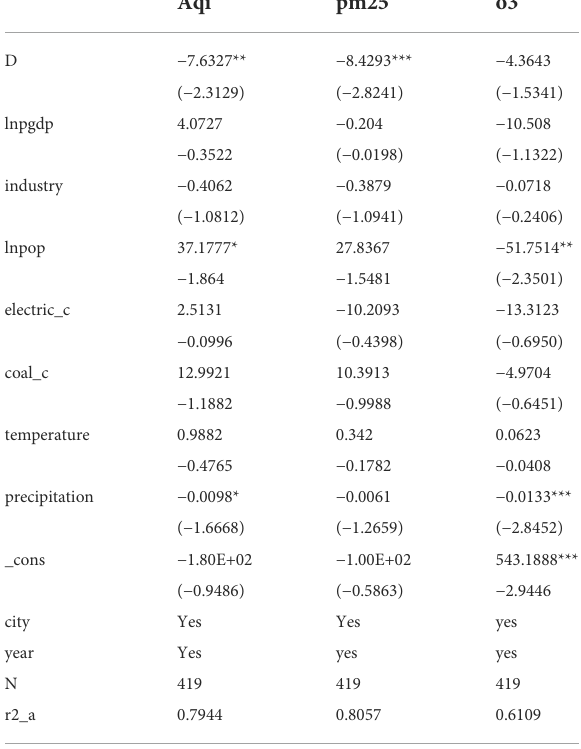
TABLE 2 Estimation results of the effects of